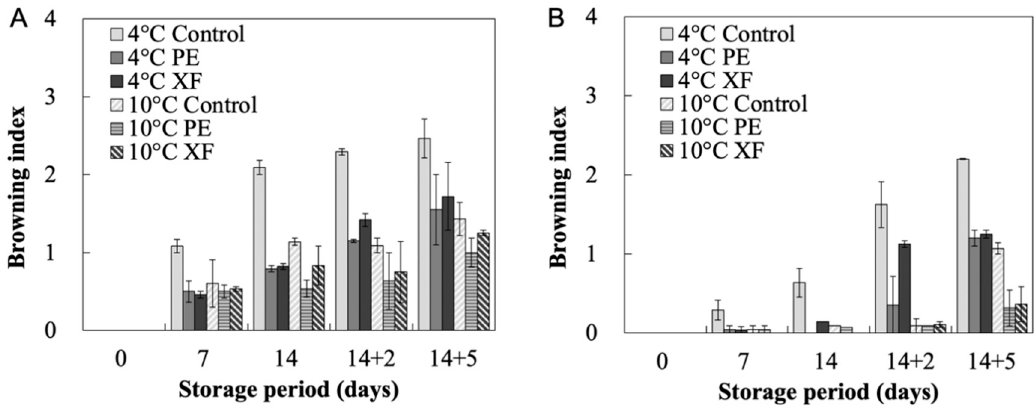
Figure 3. E ff ect of modified atmosphere packaging on peel browning symptom of white linear sutures ( A ) and peel ( B ) of oriental melons. The fruits were packaged in a commercial box made of polyethylene (PE) or Xtend film (XF) and stored at 4 ◦ C or 10 ◦ C for 14 days (14). Afterwards, the melons were transferred to 20 ◦ C condition for five days (14 + 5). Fruits stored in a standard commercial box were used as controls.